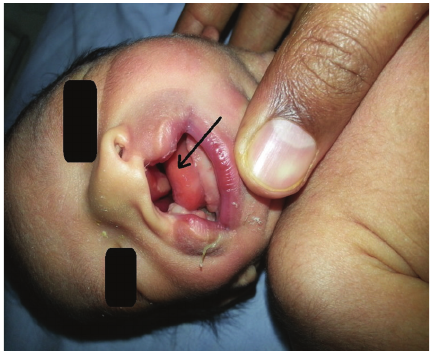
Figure 2: Bilateral complete cleft palate, cleft extending to nasal cavity.